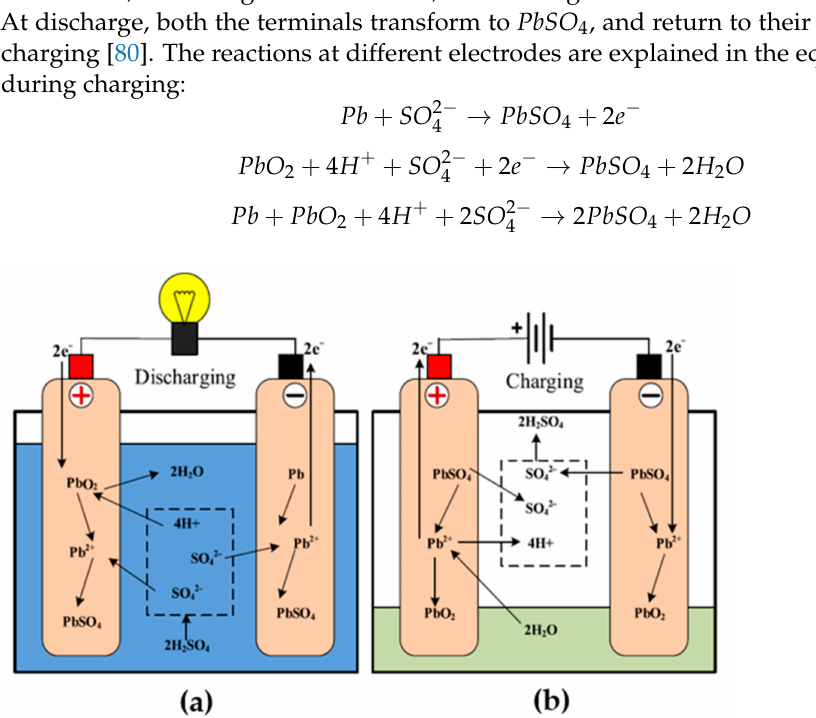
Figure 7. Chemistry of lead acid-based battery, ( a ) during discharging, ( b ) during charging